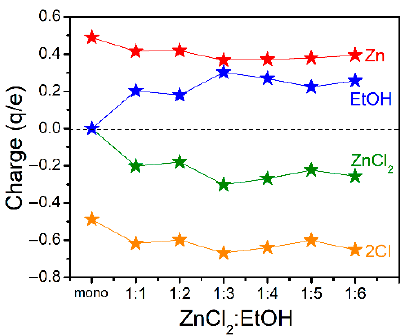
Figure 3. Hirshfeld charges (q/e) on selected atoms and molecules of ZnCl 2 and EtOH and their complexes. In the figure, mono means monomer (ZnCl 2 or EtOH).